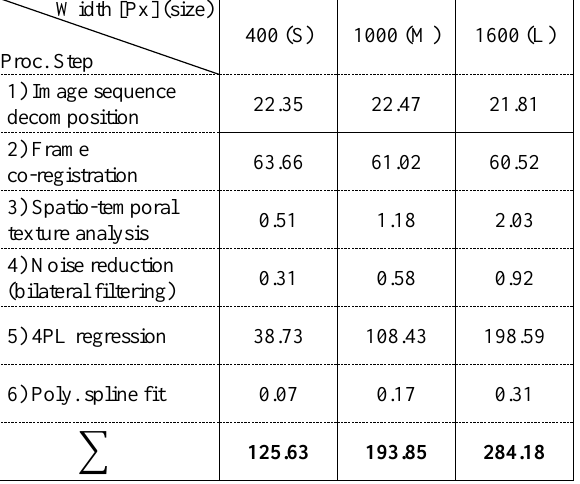
Table 2: Processing times relating to image size in